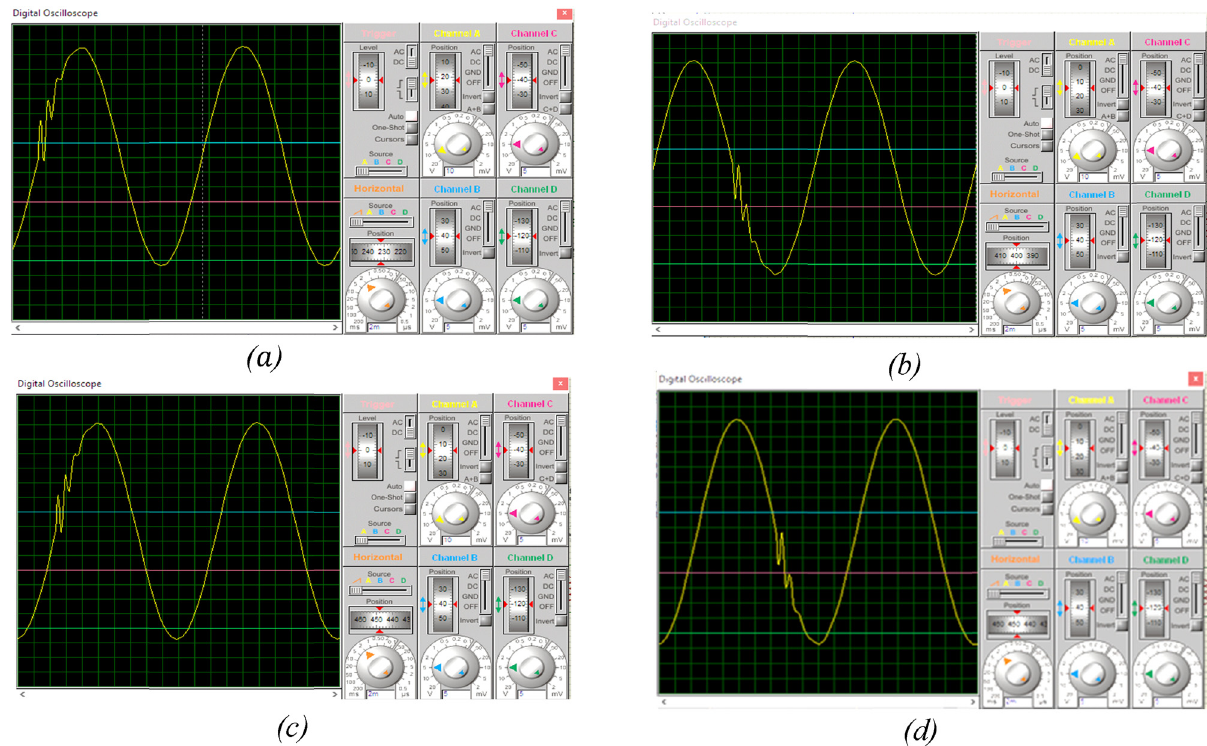
Figure 9: PD location. ( a ) PD hit due to C 1 . ( b ) PD hit due to C 2 . ( c ) PD hit due to C 3 . ( d ) PD hit due to C 4 .